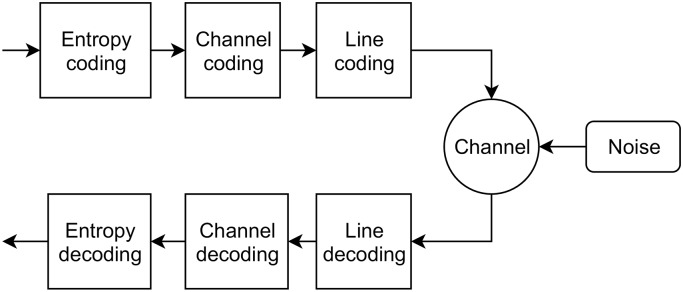
Entropy, channel and line coding.The nested entropy coding, channel coding and line coding stages in a communication channel [60].